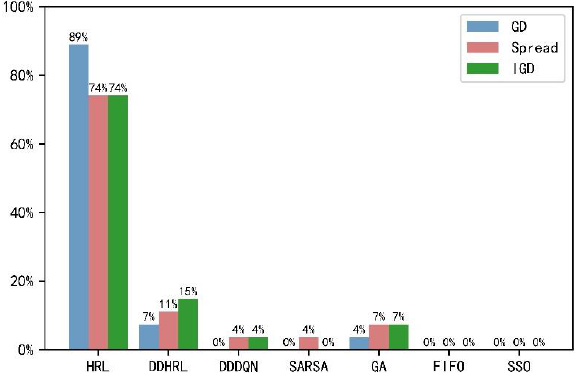
Figure 6. Winning rate of HRL and other compared algorithms.